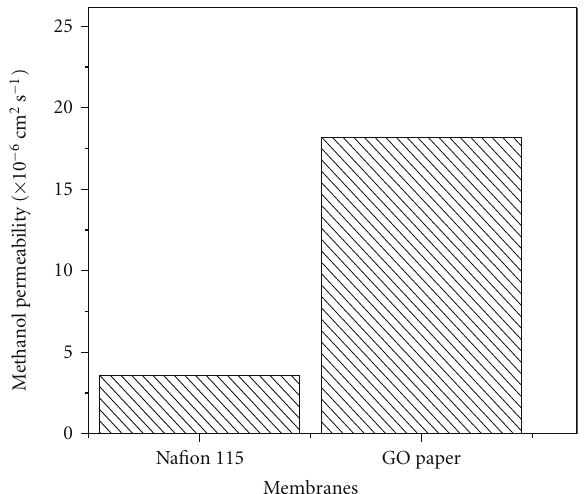
Figure 7: Methanol permeability of Nafion 115 and Graphite oxide